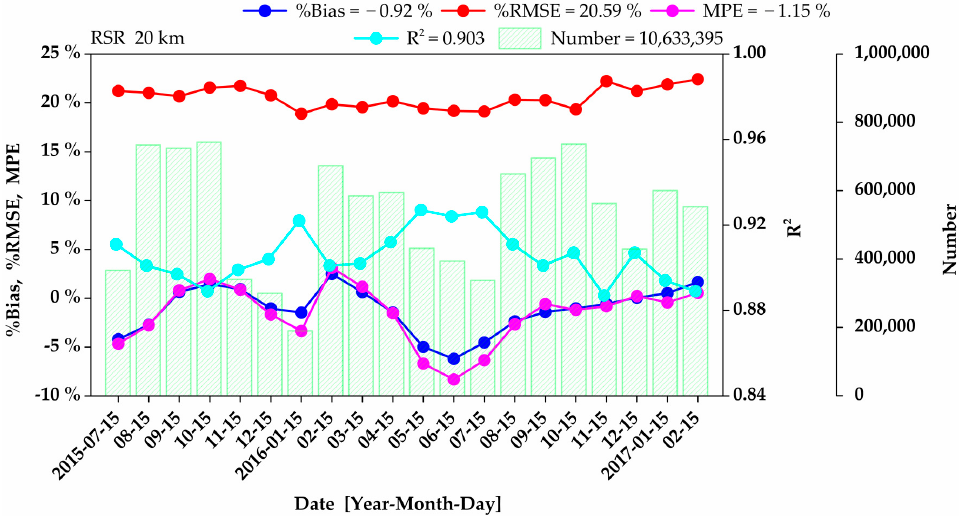
Figure 6. Statistical analysis of RSR using Himawari-8/AHI and Terra, Aqua, and S-NPP/CERES data for the 15th day of each month from July 2015 to February 2017 (%Bias: blue dotted line; %RMSE: red dotted line; MPE: magenta dotted line; R 2 : cyan dotted line; Number: green bar chart). The legend shows the statistical results for the all